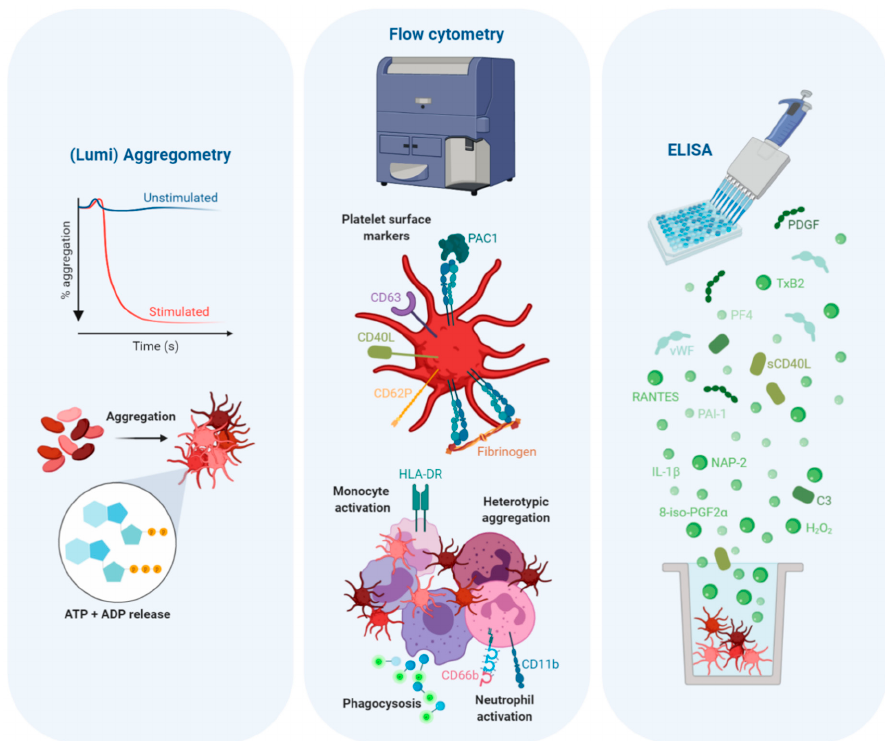
Figure 4. A summary of the techniques and associated measurements that are most commonly used for assessing platelet responses to TLR